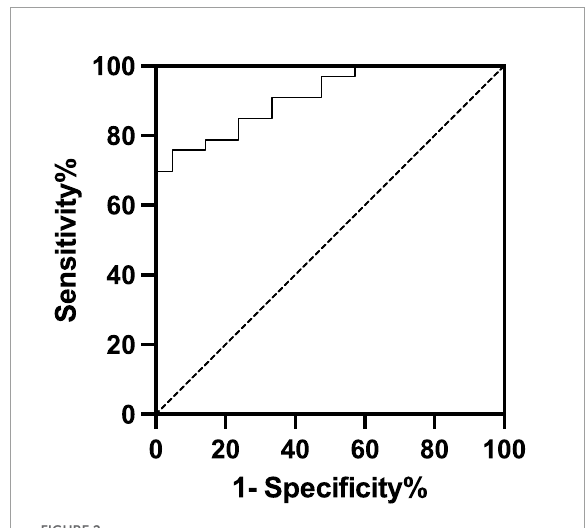
FIGURE2 Receiver operating characteristic curve of baseline baroreflex sensitivity levels for predicting the therapeutic response to metoprolol. The area under the curve was 0.912 (95% CI: 0.840–0.984; P < 0.01). Using a cut-off value for baseline baroreflex sensitivity of 8.045 ms/mmHg yielded both sensitivity of 75.8% and specificity of 95.2% in predicting the efficacy of metoprolol on postural orthostatic tachycardia syndrome. The y -axis represents the sensitivity to predict the effectiveness of different BRS levels in metoprolol therapy. The x -axis represents the false-positive rate (1-specificity) of the